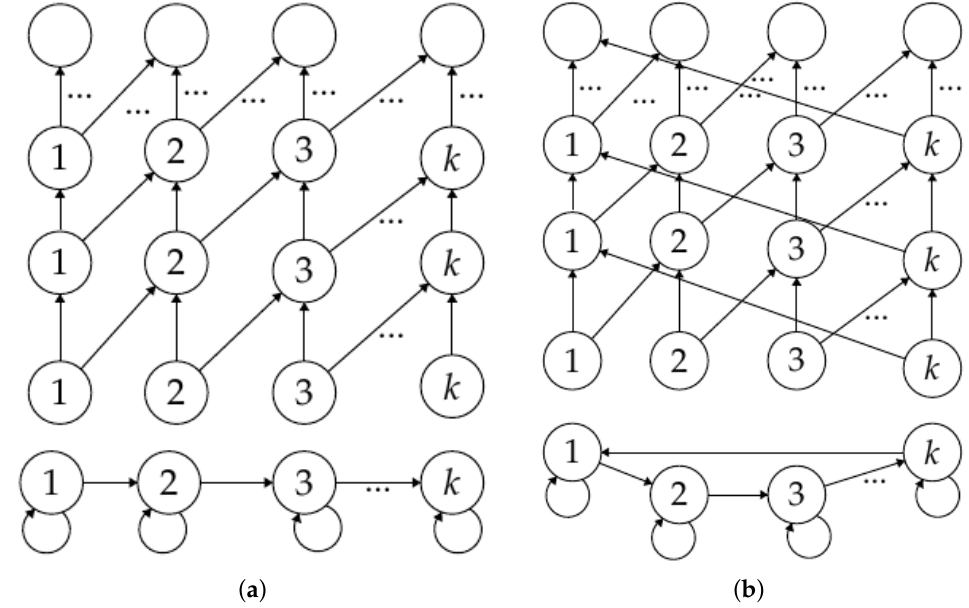
Figure 2. Directed labeled graphs and their correponding base diagrams. ( a ) A path( l ) and its corresponding base diagram tellis ( l ). ( b ) A cyc ( l ) and its corresponding base diagram cylinder( l ).